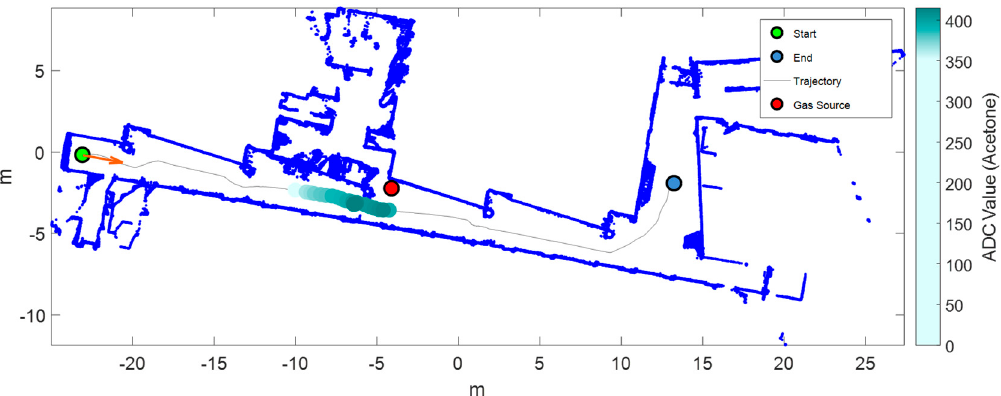
Figure 9. Results of exploration with one gas source of acetone and heating, ventilation, and air conditioning (HVAC) turned off (Scenario II). Map of the arena (built by the robot) and mean sensor array response overlaid on the robot trajectory.